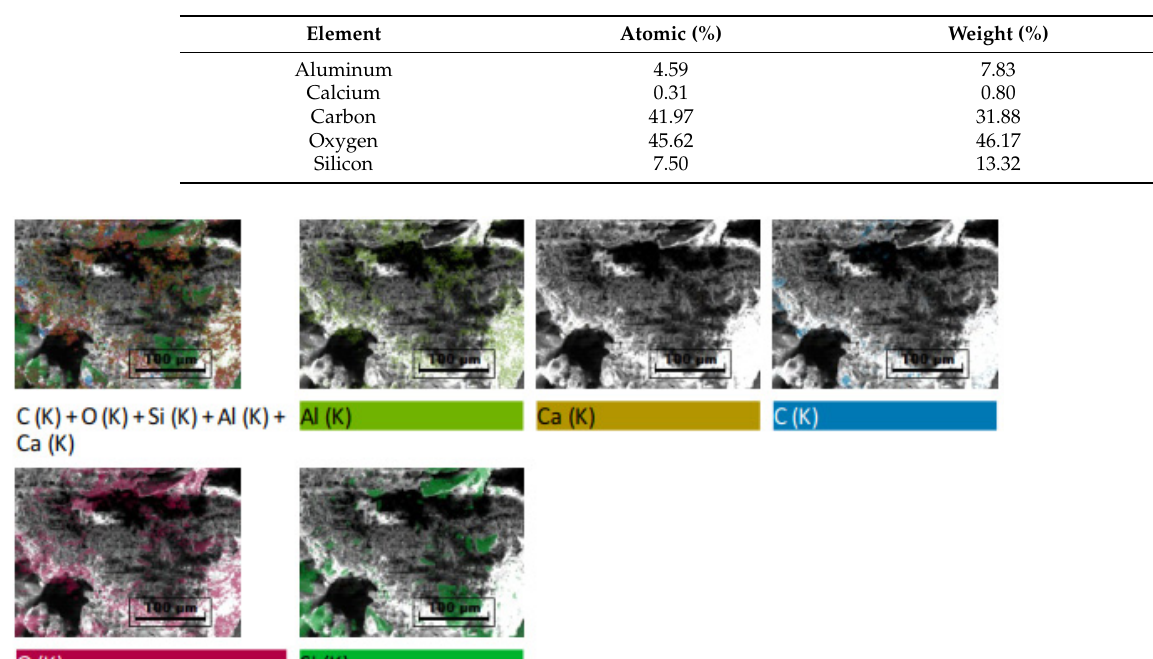
Table 1. Quantitively elemental analysis of peat.